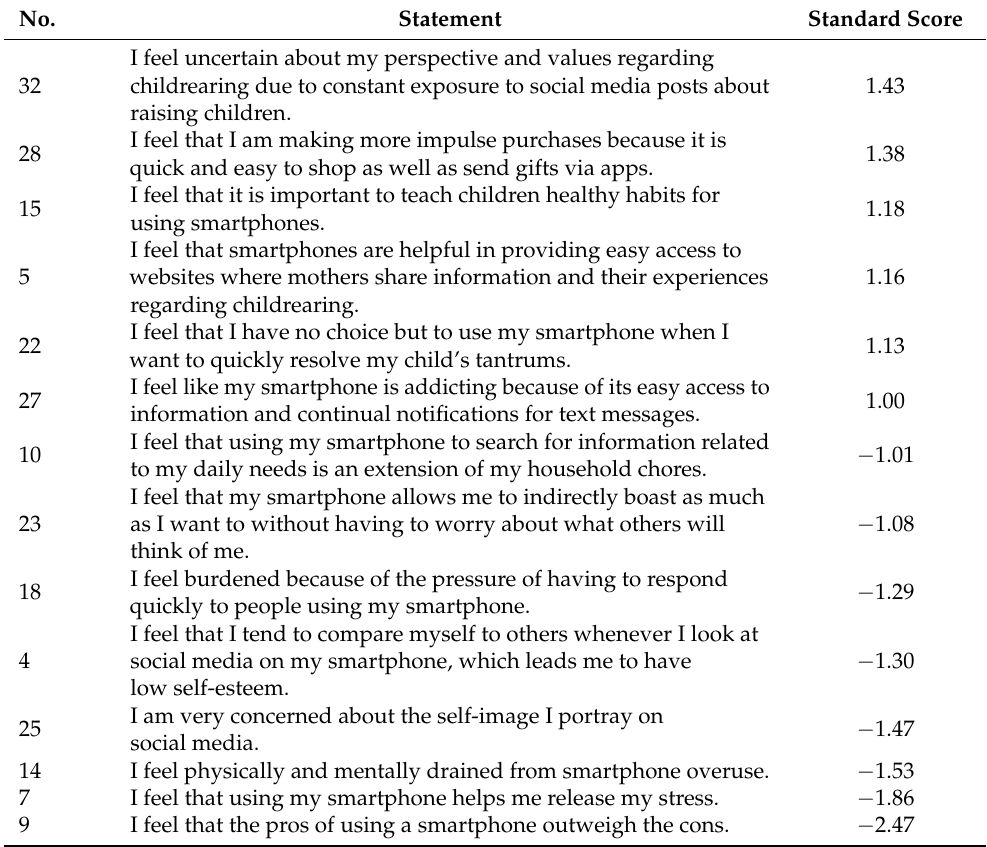
Table 4. Statements and standard scores for Type 2 ( ≥±